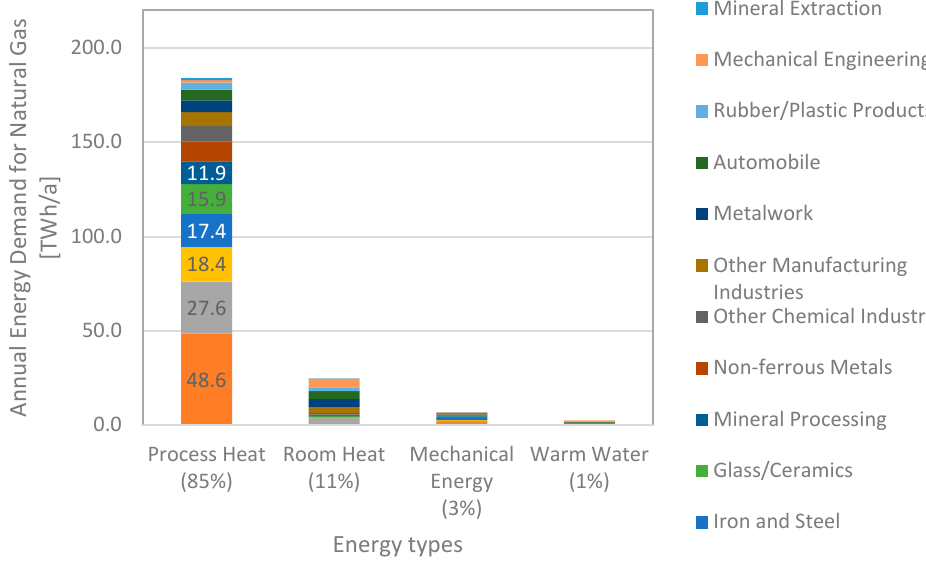
Figure 2. Annual natural gas demand in industry in 2019. Authors’ illustration based on [21].